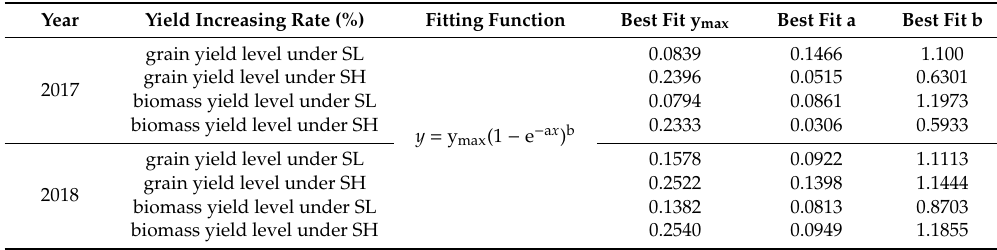
Figure 6. Relationships between the water use efficiency and straw incorporation rate in 2017 and 2018. Note: GYSL and GYSH indicates the grain yield increasing rate under the SL and SH irrigation water conditions, respectively; BYSL and BYSH indicates the biomass yield increasing rate under the SL and SH irrigation water conditions, respectively. Table 7. Fitted parameters of the regression function between the yield (grain and biomass) increasing rate and straw incorporation rate .